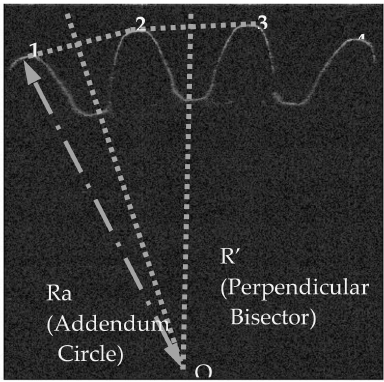
Figure 4. Calculation of tooth number using optical coherence tomography imaging by employing the tooth tip or the root position of any three teeth. Labels of 1, 2, 3, and 4 are the tip positions. Ra : the radius of the addendum circle. R (cid:48) : the perpendicular bisector of any two top-line